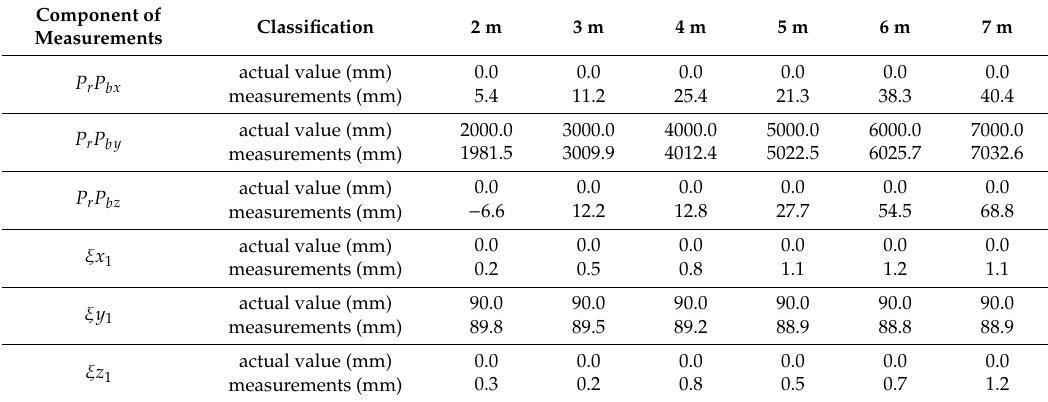
Table 1. Experimental data of a measuring device based on the outer circle positioning of the pipe. Component of